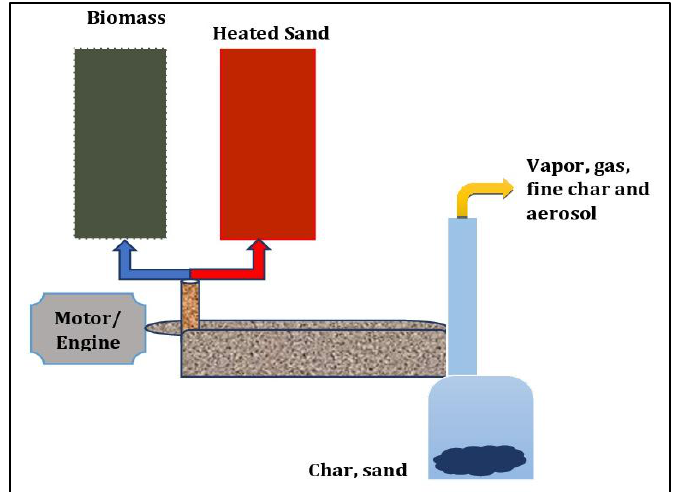
Figure 9. Auger pyrolysis reactor [96].